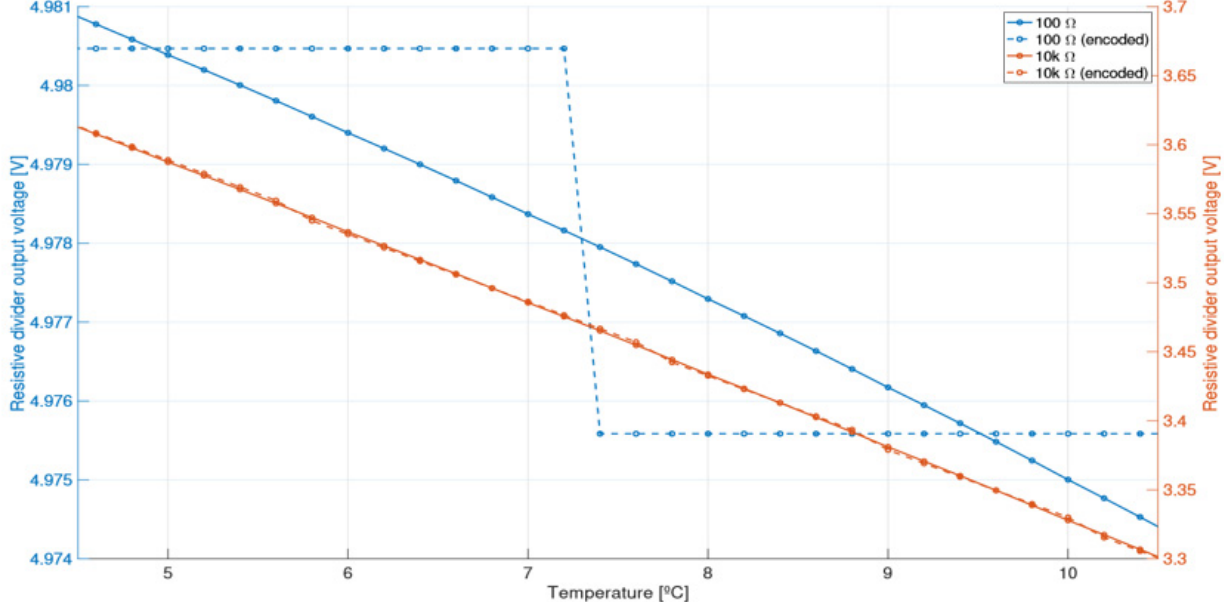
Figure 25. Resistive divider output voltage for the lowest and intermediate series resistor’s values, compared with the same encoded values for a 10 bit ADC, across the operational temperature range.